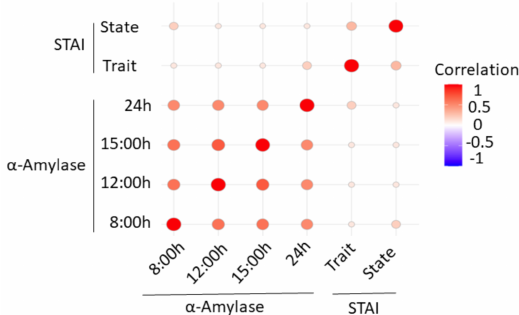
Figure 2. Correlation chart of α -amylase levels determined at 8 h (197.6 ± 37.1 U/mL), 12 h (283.8 ± 35.3 U/mL), 15 h (302.4 ± 35.6 U/mL), 24 h (239.7 ± 29.2 U/mL) [38] and STAI scores.